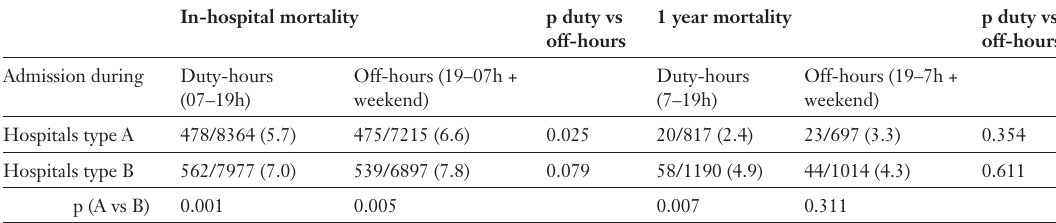
Results of multivari- ate regression analyses. Hospital type adjusted for age, gen- der, risk factors, type of ACS and comor- bidities as independ- ent predictor of: